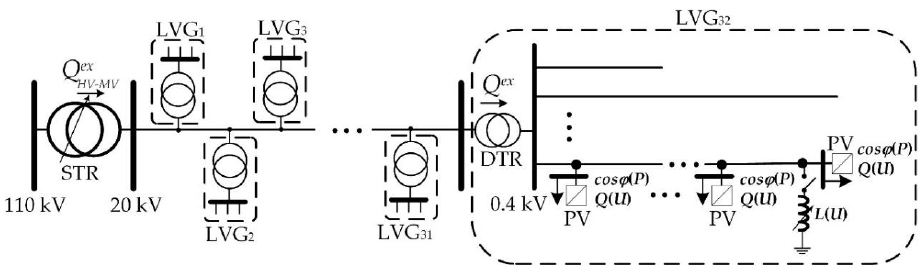
Figure 21. Schematic representation of a medium-voltage grid (MVG) combined with the respective LVGs.